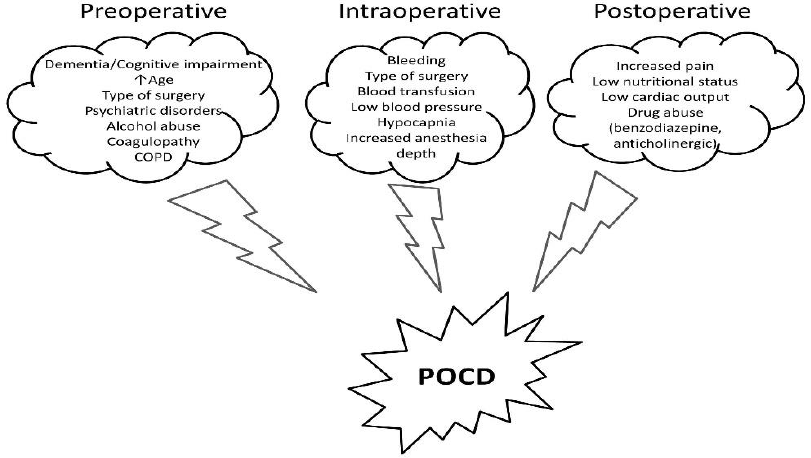
Figure 1. Risk factors and intervention strategies for POCD. POCD- postoperative cognitive dys- function, COPD- chronic obstructive pulmonary disease.